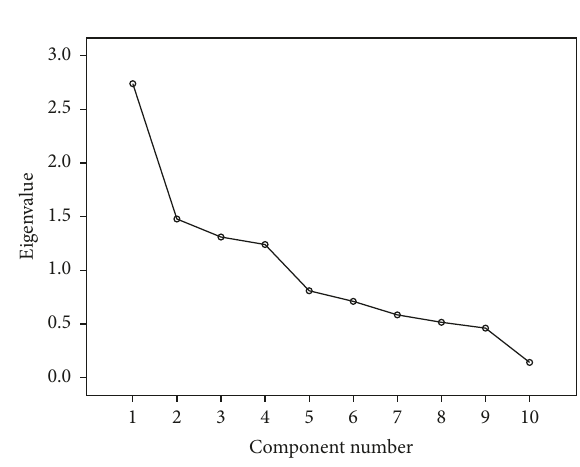
Figure 3: Scree plot for attitude domain: construct validity.